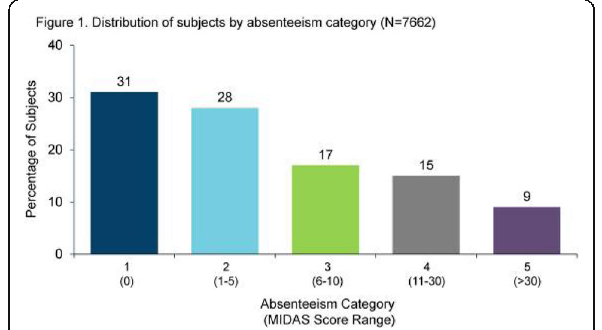
Fig. 1 (abstract AL014). See text for description